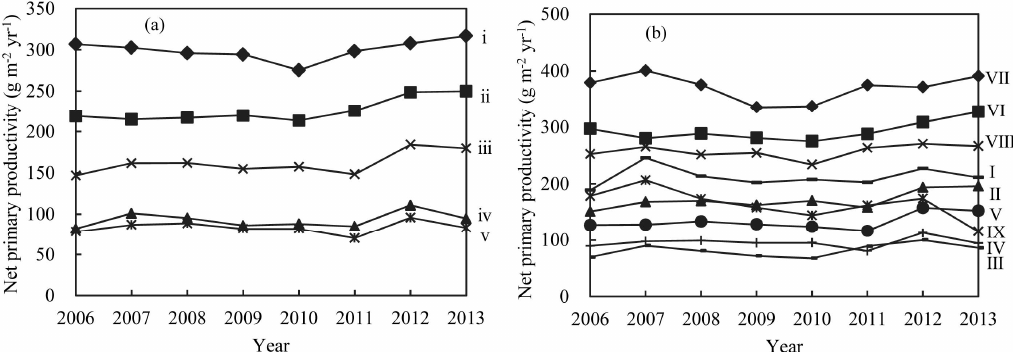
Figure 5. Yearly NPP data for the new regionalization scheme ( a ) and the Chinese eco-geographical regionalization scheme ( b ) in different years. i: Forested lands; ii: woody grasslands/bushlands; iii: grasslands; iv: xerophytic shrublands and semi-shrublands; v: passive restoration lands. I: Area of coniferous forest and grasslands in the basin east of the Qilian Mountains; II: steppe region in the north-central portion of the Loess Plateau; III: desert area in Alxa and the Hexi Corridor; IV: desert grassland area in Erdos and western Inner Mongolia; V: grassland area in eastern Inner Mongolia; VI: deciduous forest and farmland in the Fenwei basin; VII: area of evergreen broadleaf forest and mixed forest in the Qinba Mountains; VIII: area of deciduous broadleaf forest in the mountains of northern China; IX: area of farmland on the North China Plain.